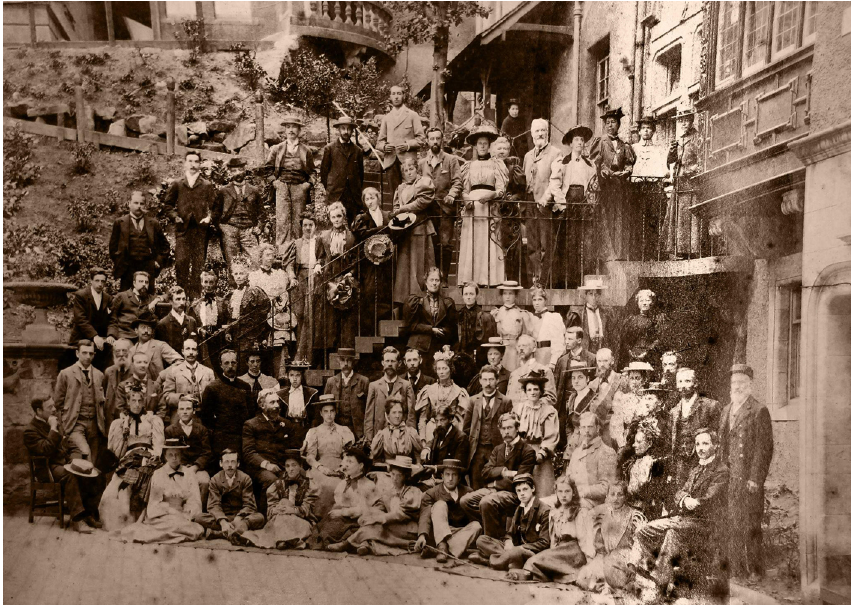
Fig. 11 Summer meeting 1896, SUA, T. GED 22/3/27 (no. 1), Glasgow, Strathclyde